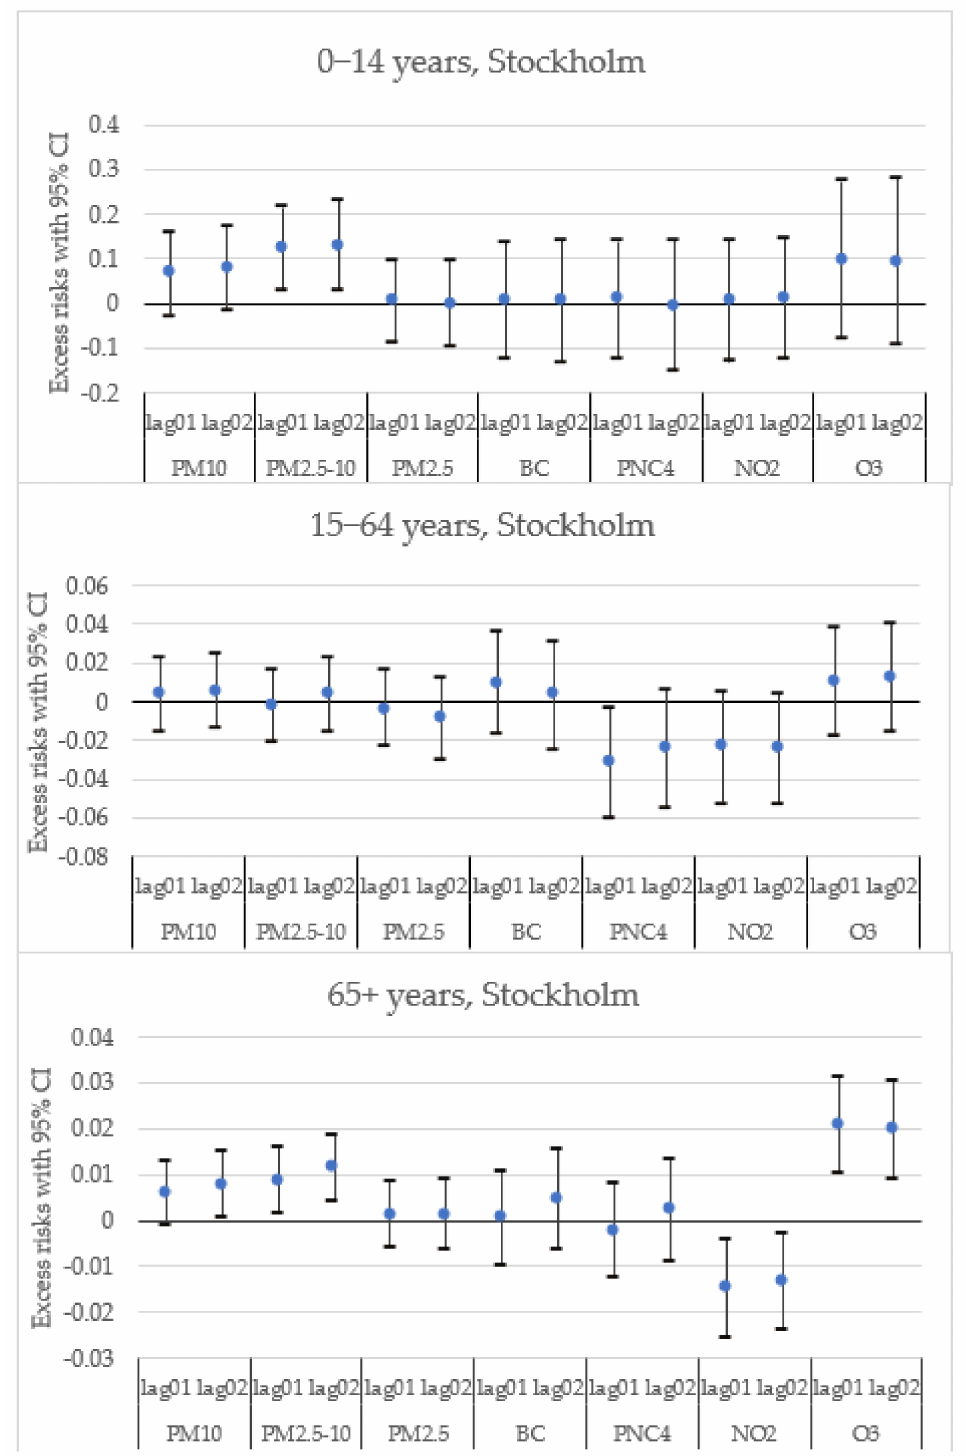
Figure 1. Single-pollutant models of the estimated change in daily mortality in different age groups (with 95% CI) for an IQR increase in the concentrations (lag01 and lag02) of different air pollutants in